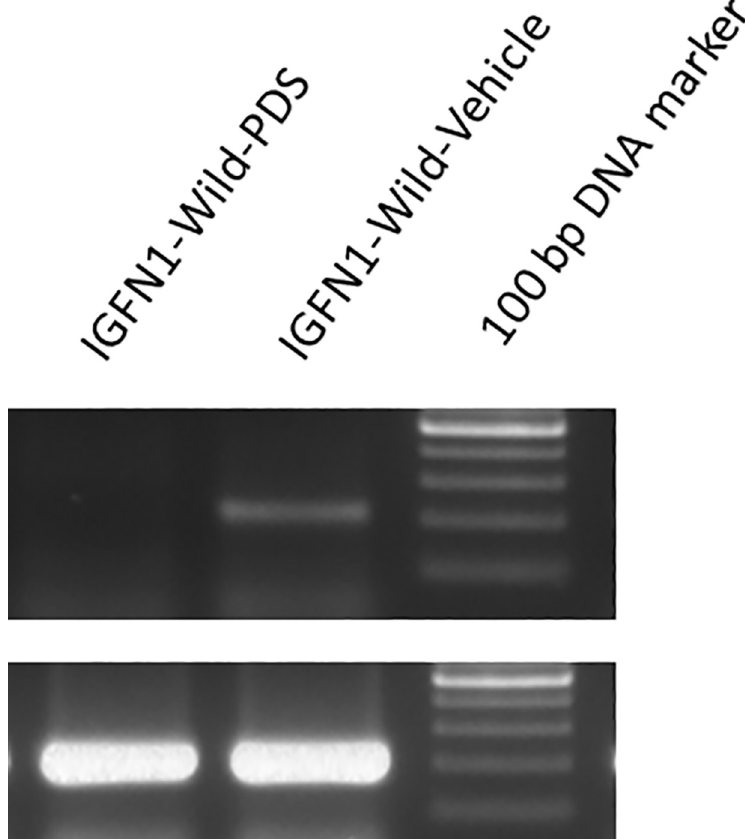
Fig 7. PDS stops reverse transcriptase elongation leading to the inhibition of RT-PCR amplification. Upper panel shows the RT-PCR amplification inhibition by PDS whereas this inhibition is absent in control. Lower panel shows the amplification of GAPDH, no difference in amplification is observed between PDS and